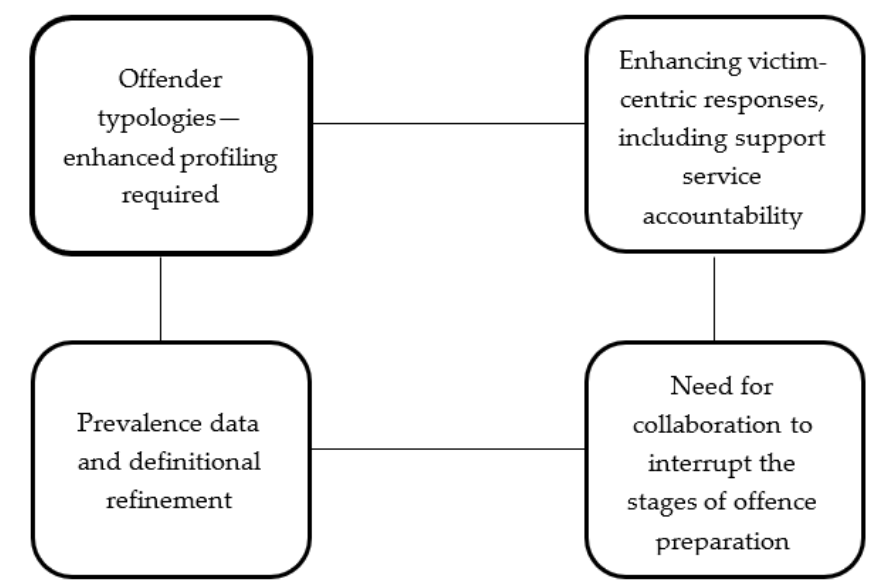
Figure 1. Thematic summary of overall priorities identified at the roundtable discussion.